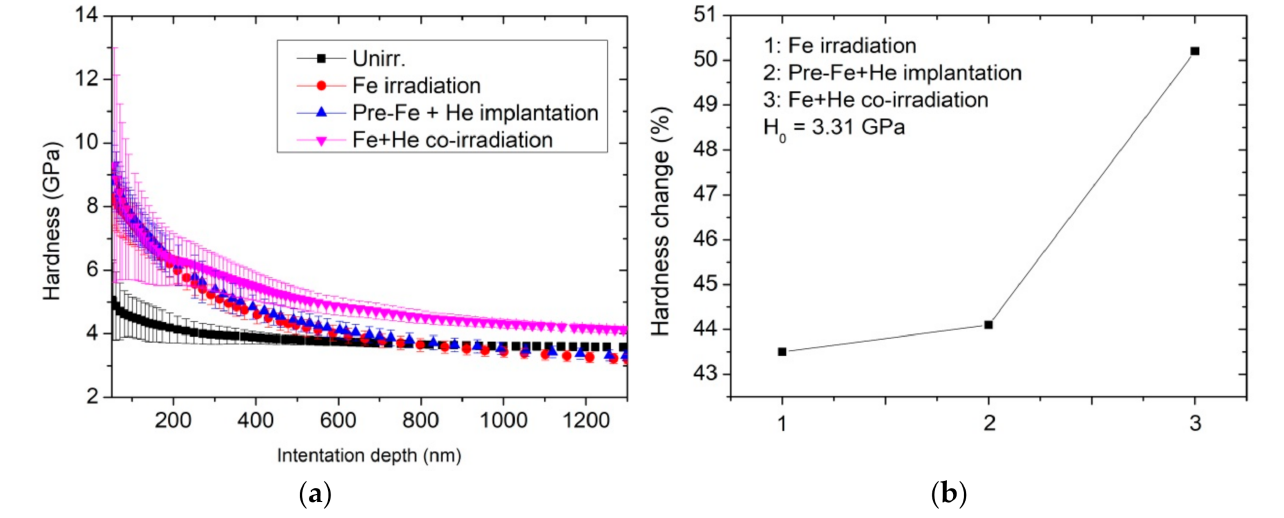
Figure 2. ( a ) Indentation-depth dependence of the nano-indentation hardness of samples after Fe irradiation, Fe pre- irradiation + He implantation and Fe + He co-irradiation, compared to the as-irradiated sample, ( b ) the hardness change (%) after three different irradiation